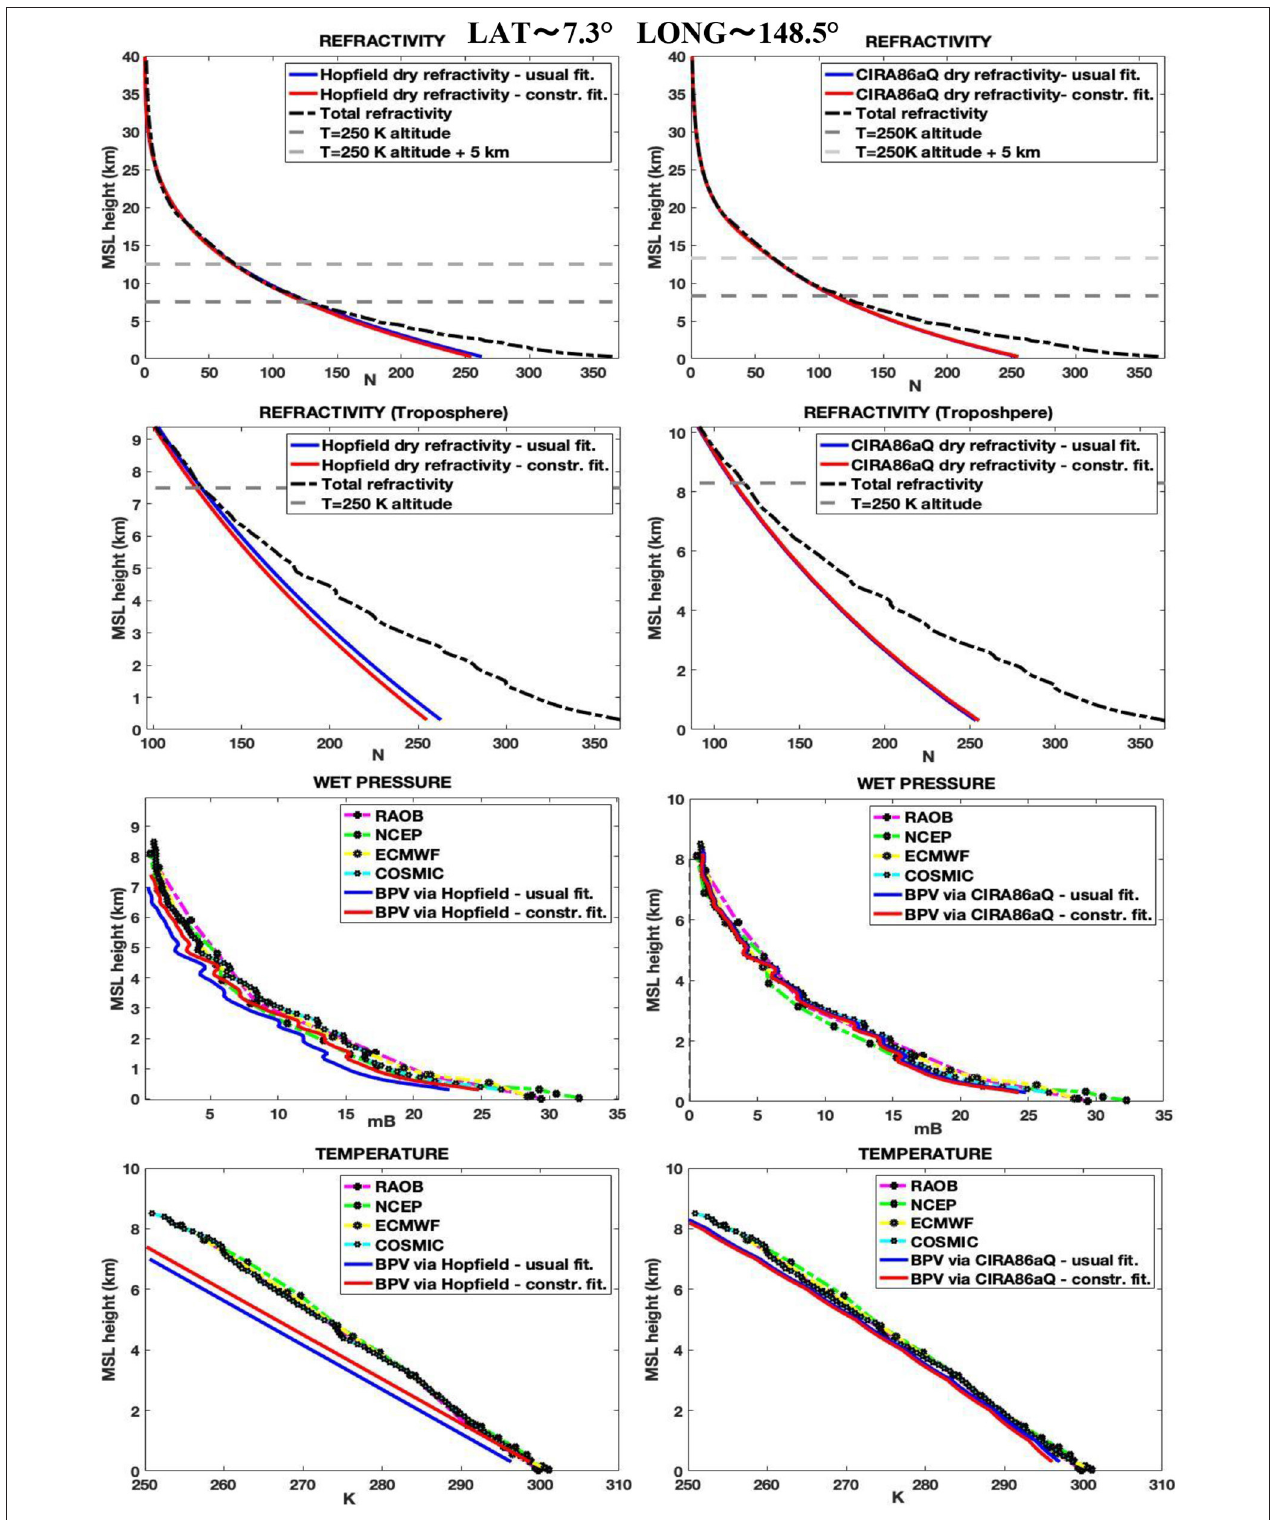
FIGURE 4 | Refractivity, tropospheric refractivity, wet pressure and temperature profiles for a near-equatorial location. The graphs are obtained by the BPV and the previous BPV method without the second constrained fitting, for both the Hopfield (left) and CIRA86aQ (right) dry refractivity models. ECMWF, NCEP, COSMIC, and RAOB profiles are also reported for